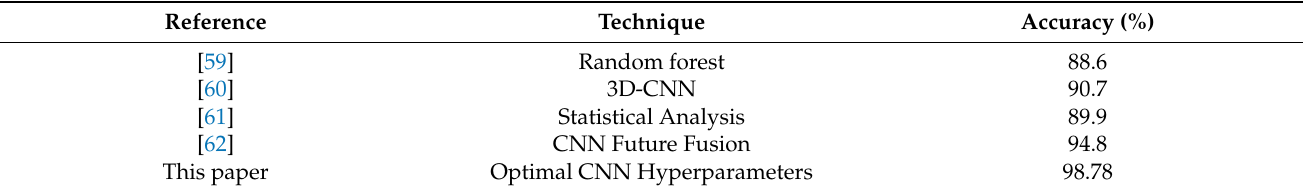
Table 12. CT data set performance